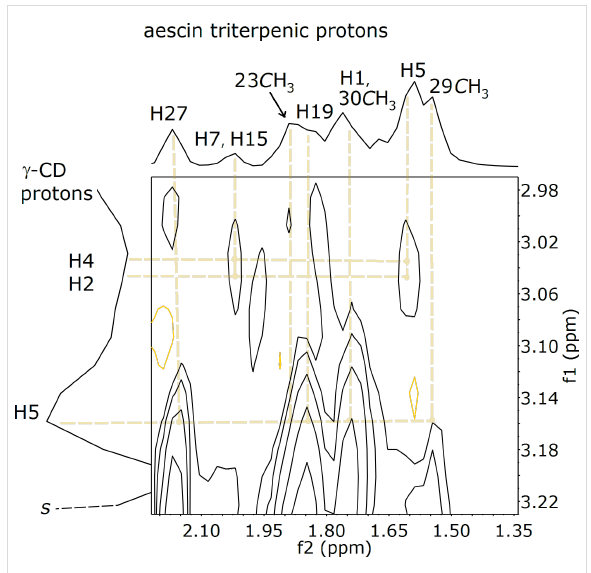
Figure 4: Partial 2D ROESY spectrum of a water/methanol solution containing equimolar amounts of γ -CD and